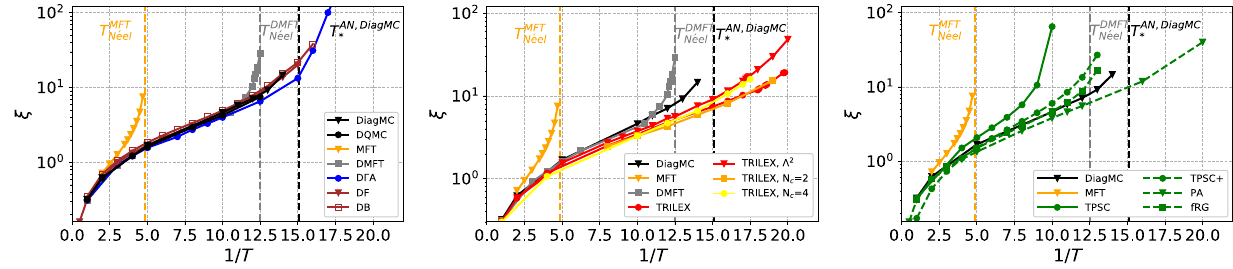
FIG. 16. Magnetic correlation lengths ξ extracted from the magnetic susceptibility as a function of (inverse) temperature for various methods on a logarithmic